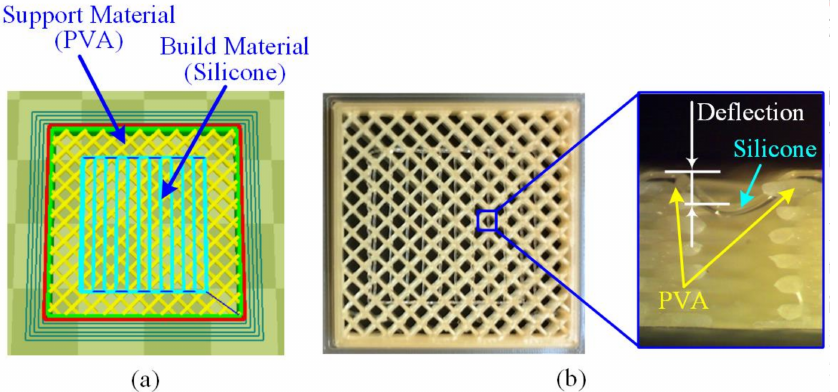
Figure 3. Illustration of the test setup to determine minimum infill density: ( a ) toolpaths for build and support materials and ( b ) an example of the printed sample and a close-up view of the sliced sample for measuring the deflection between the support